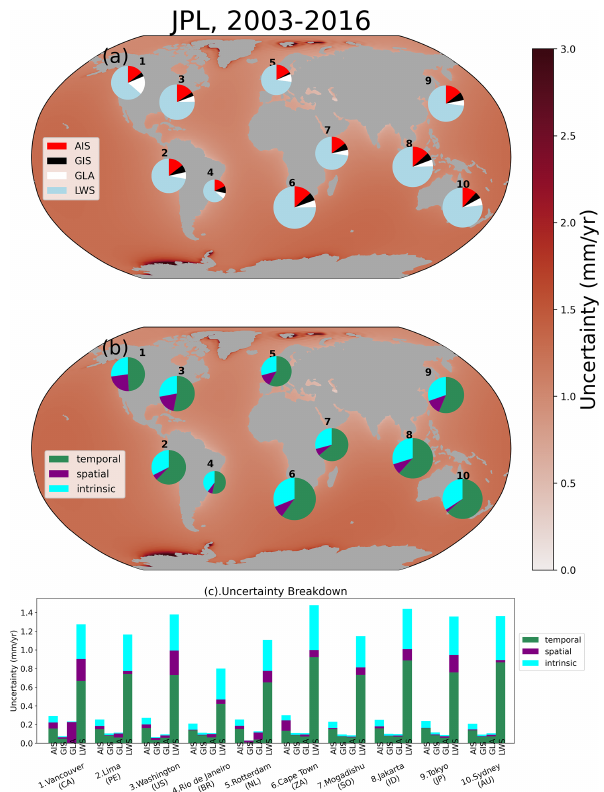
Figure B6. Same as Fig. 8, for the JPL dataset, from 2003–2016.